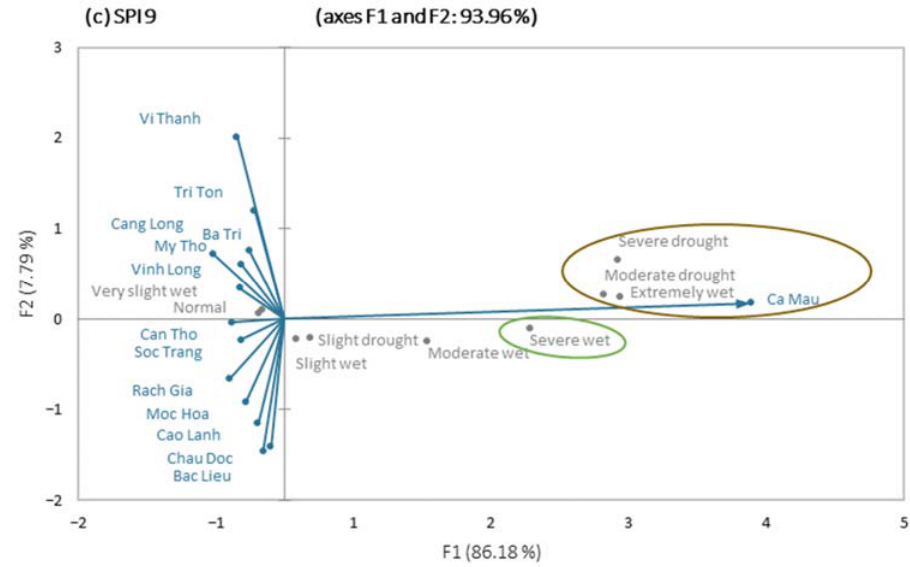
Figure 3. Symmetric plot of correspondence analysis for SPI 3 ( a ), SPI 6 ( b ), and SPI 9 ( c) .